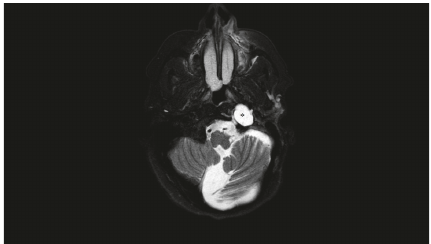
Figure 4: Axial postcontrast T1 weighted image shows CSF and meninges herniated to the left jugular foramen without enhance- ment (∗)